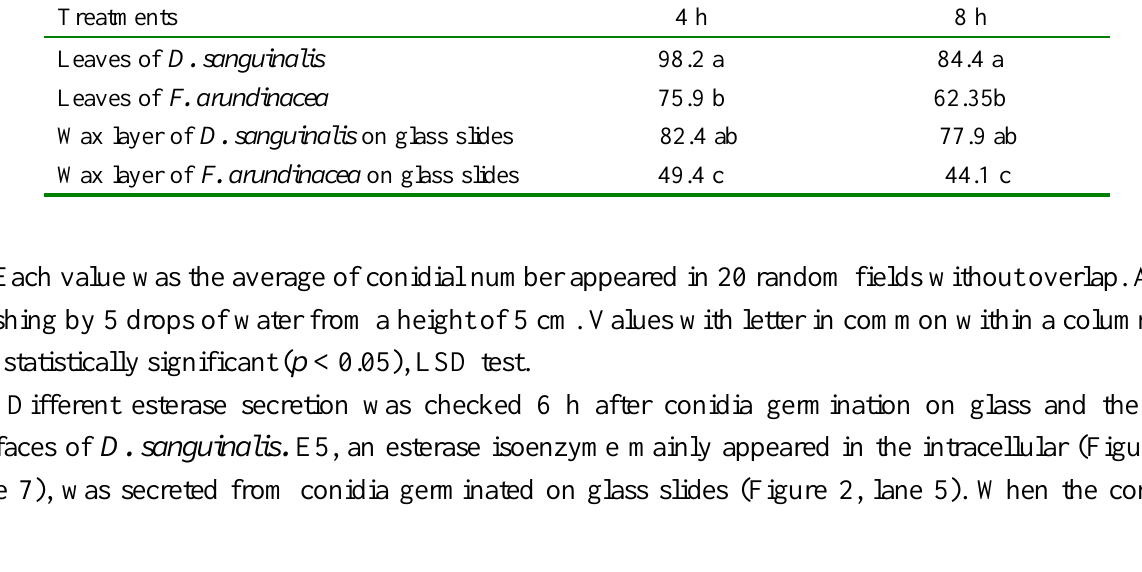
Table 1. Conidial number of C. eragrostidis adhered to the surface of leaves of D. sanguinalis and F. arundinacea and wax layer from the two plants on glass slides Treatments 4 h 8 h Leaves of D. sanguinalis Wax layer of D. sanguinalis on glass